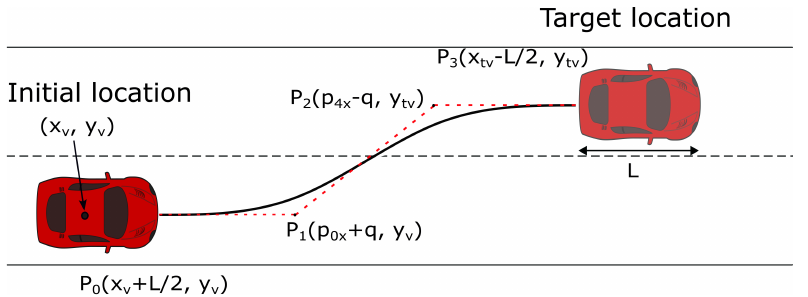
Figure 4. Lane changing cubic Bézier